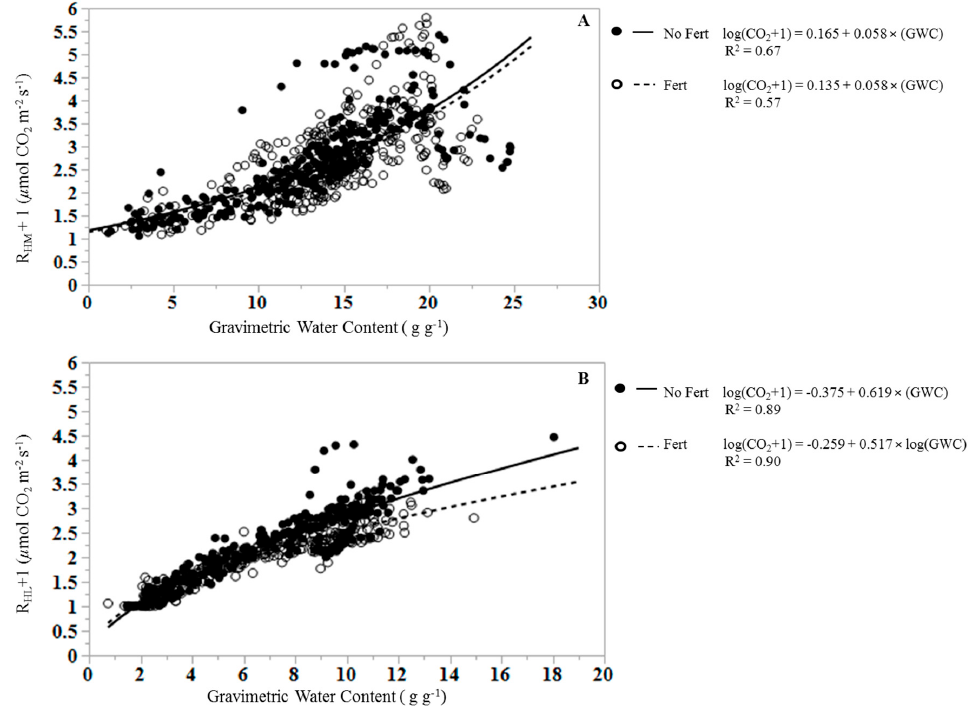
Figure 3. Relationships between ( A ) mineral soil heterotrophic respiration (R HM ) and soil gravimetric water content (GWC), and ( B ) leaf litter heterotrophic respiration (R HL ) and leaf litter gravimetric water content (GWC) in unfertilized (closed symbols, solid line) and fertilized samples (open symbols, dashed line).